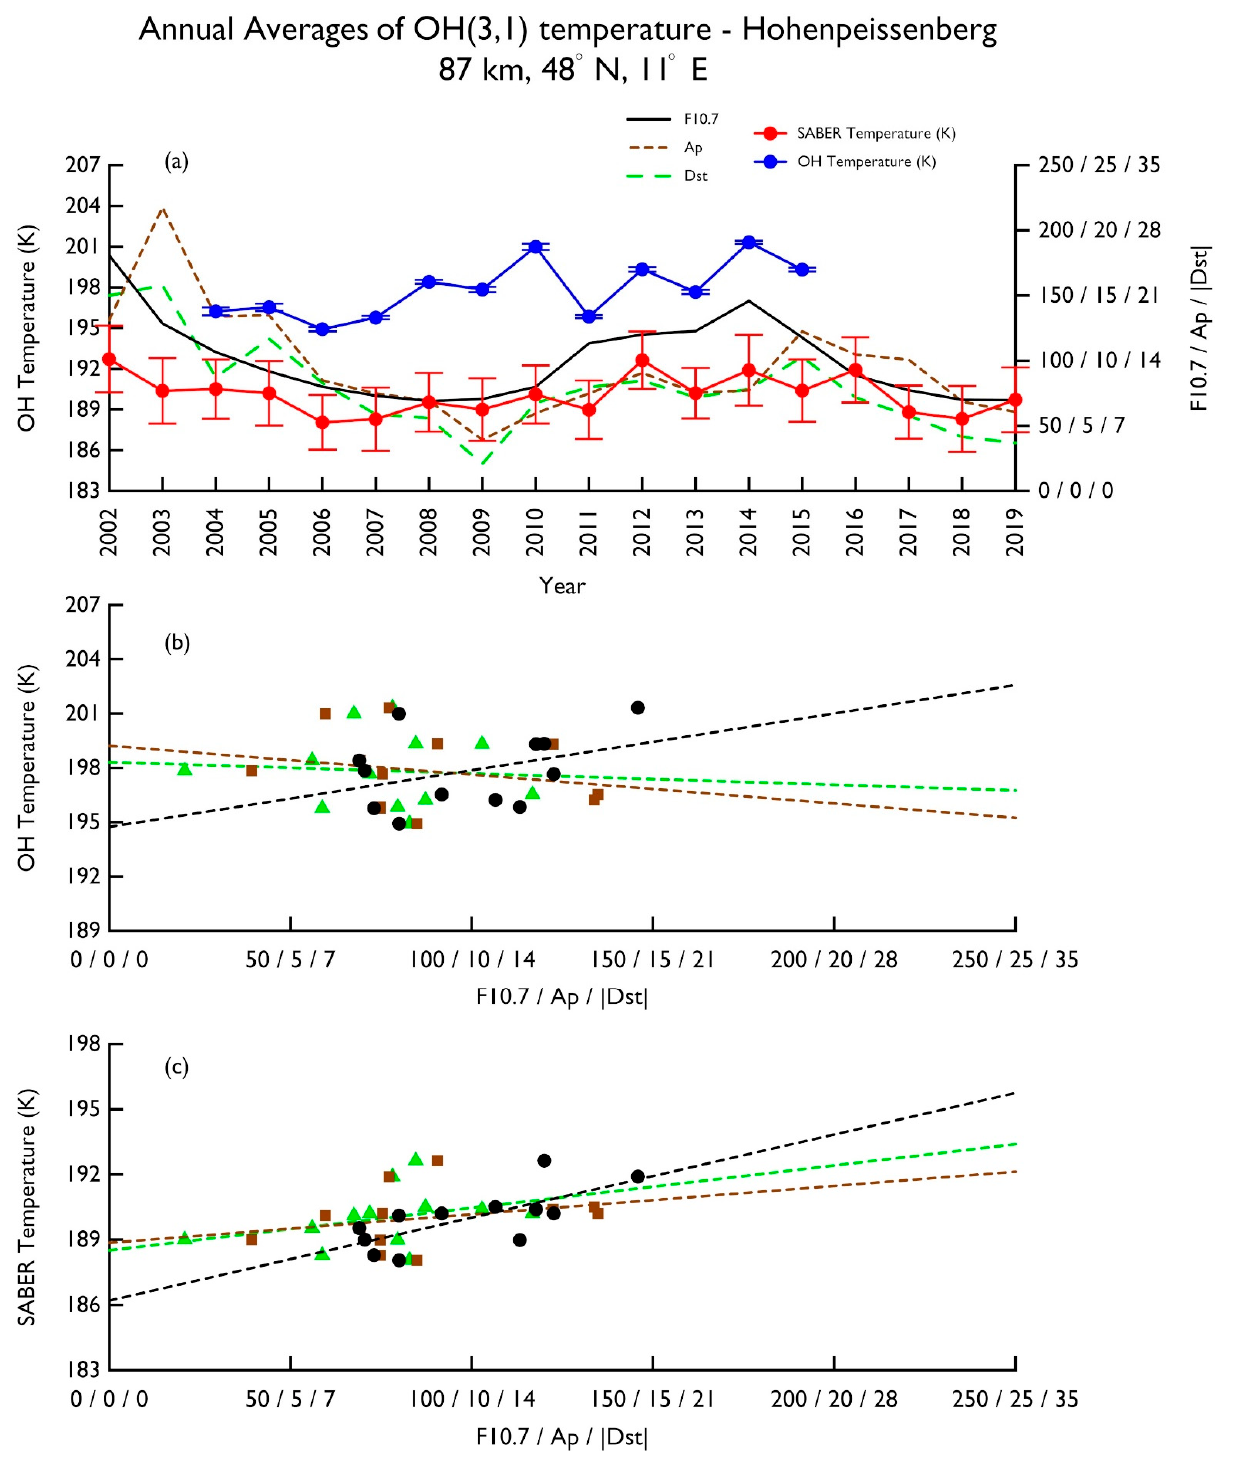
Figure 3. ( a ) Annual averages of OH(3,1) temperatures at Hohenpeissenberg (blue line with dots) and annual averages of SABER temperatures (red line with dots) at the same location at 87 km altitude. The error bars show the range of uncertainties of temperature. Also plotted are annual averages of F10.7 (black line), Ap index (brown dashed line), and |Dst| index (green dashed line). ( b ) HPB temperatures plotted as a function of F10.7 (in black), Ap index (in brown), and |Dst| index (in green) with the respective trend lines. ( c ) SABER temperatures plotted as a function of F10.7, Ap index, and |Dst| index with the respective trend lines.